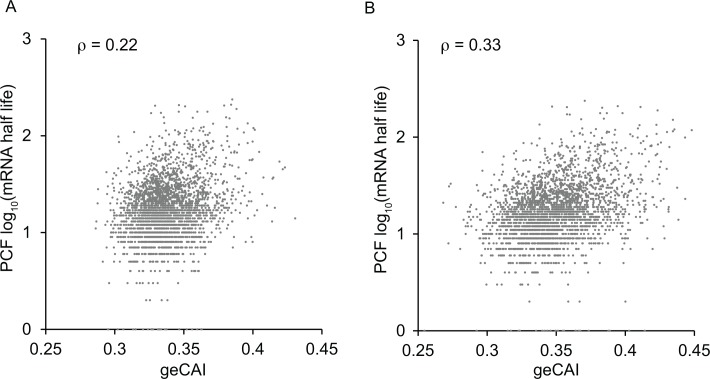
Correlation between mRNA half-lives from (Fadda et al., 2014) and geCAI scores for each ORF calculated from the transcriptome data in: (A) reference (Fadda et al., 2014); (B) this study.The Spearman’s rank correlation coefficient is given as ρ at the top of each graph.